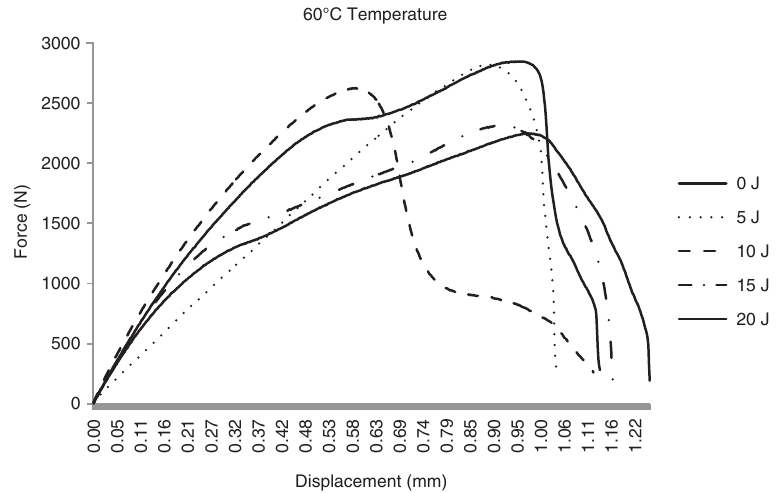
Figure 8: Effects of different impact energy values on load-displacement response at the 60 ° C temperature